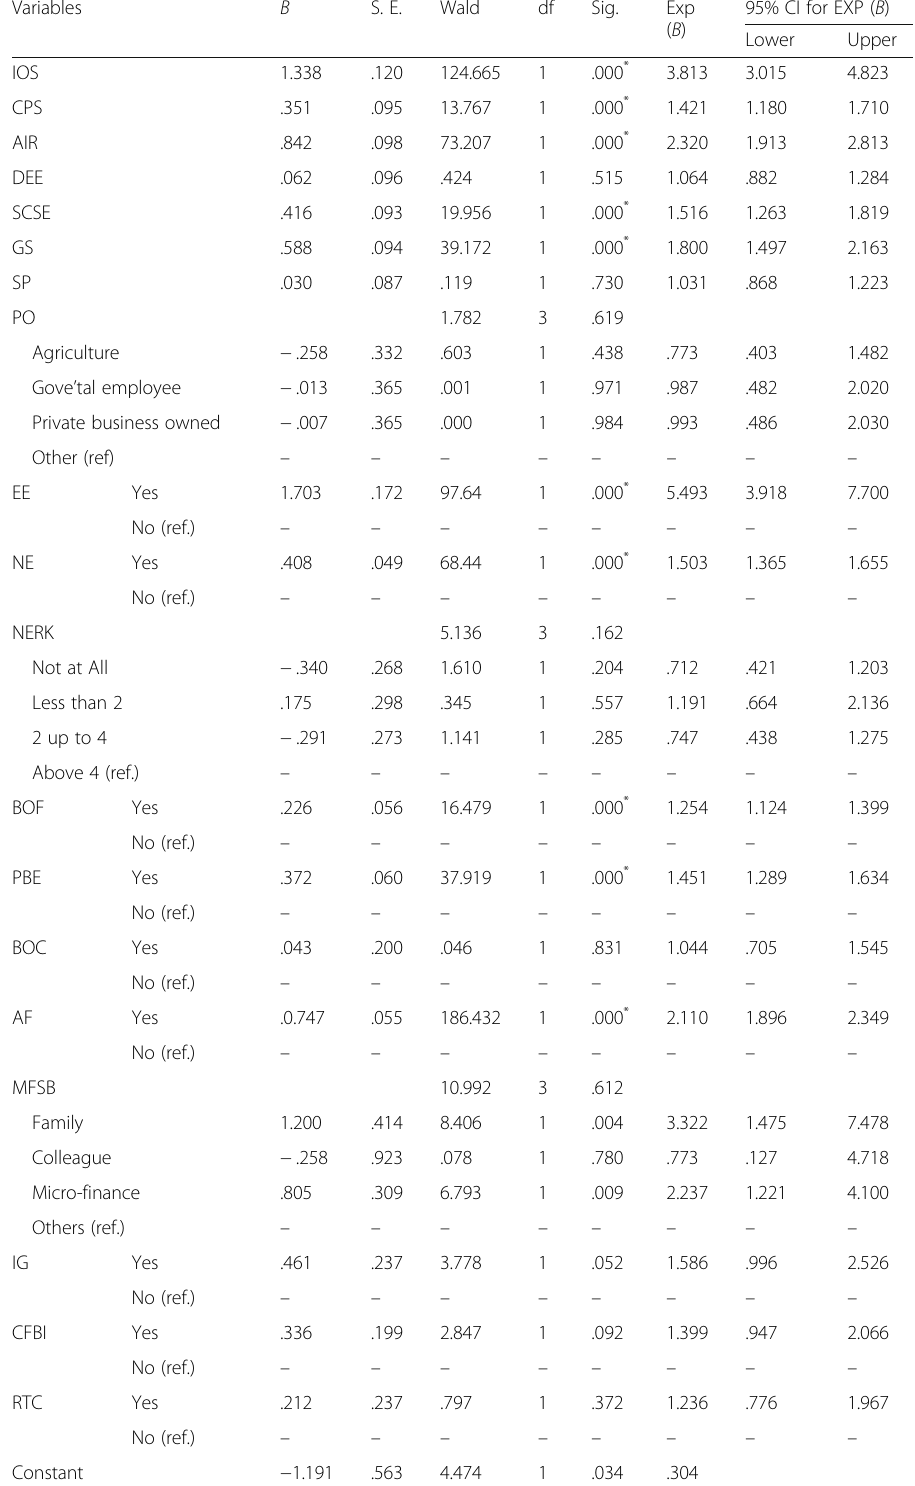
Table 8 Variables in the equation